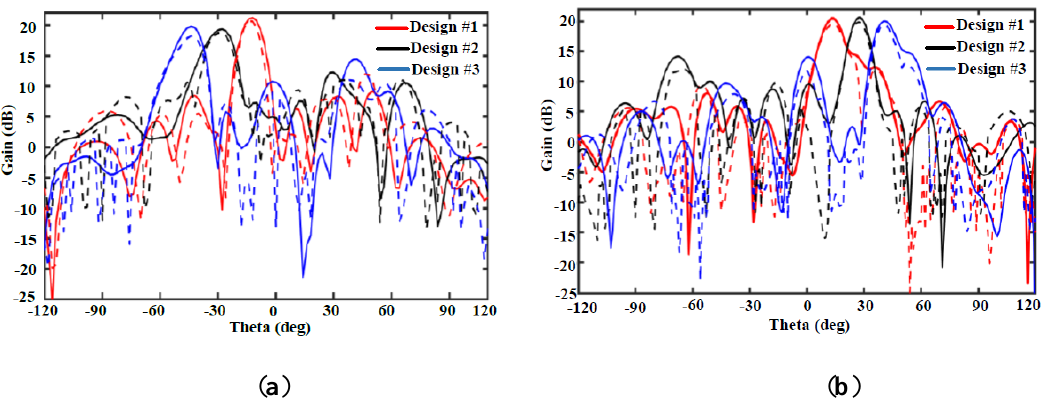
Figure 17. Simulated and measured results of the radiation patterns of the RCA in [139]: ( a ) PGS; ( b ) PDGSs